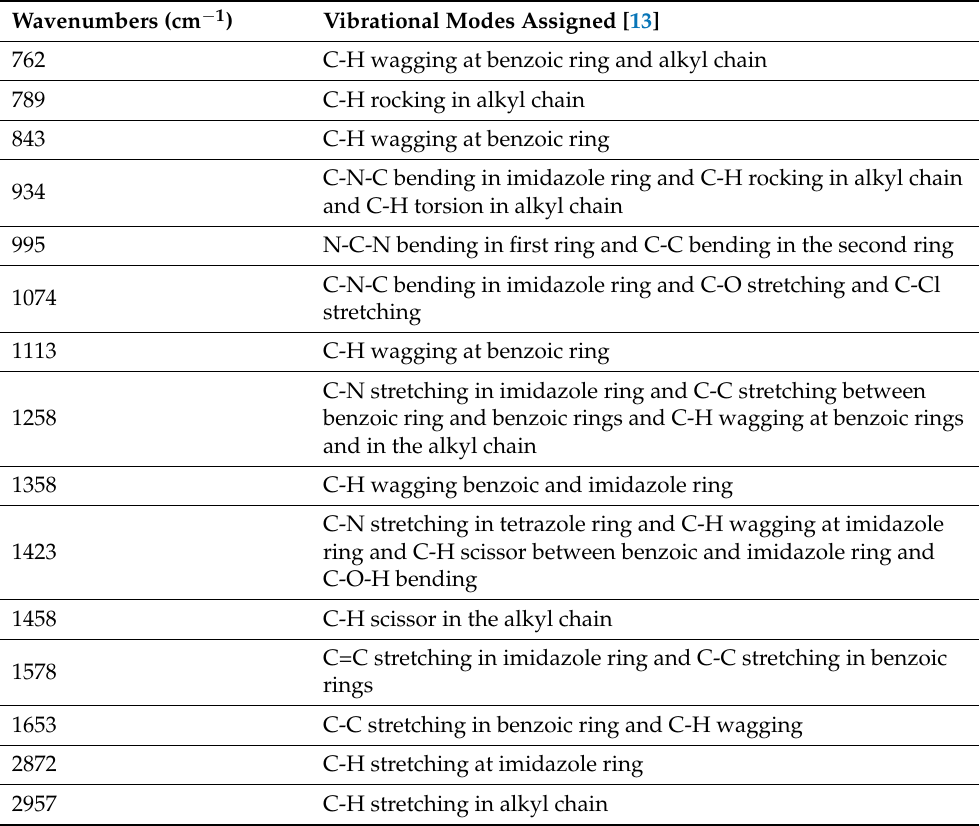
Table 2. The IR bands of LP ( 1 ) and their vibrational modes.